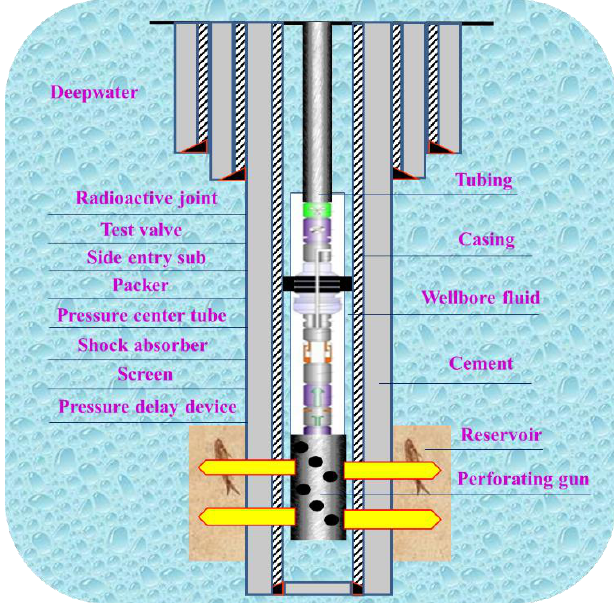
Figure 1. Downhole perforation system.